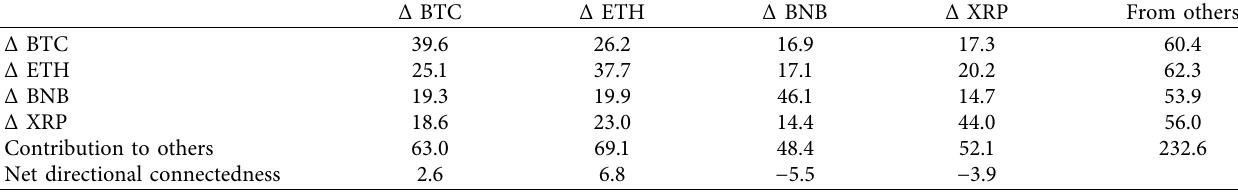
Table 3: The connectedness of selected digital currencies (each digital currency’s directional and net connectedness are shown in this table; the average connectedness of this digital currency to other digital currencies is shown by “contribution to others”; “from others” denotes the average connectedness of this digital currency from other digital currencies, and “net directional connectedness” is obtained by the former value minus the latter